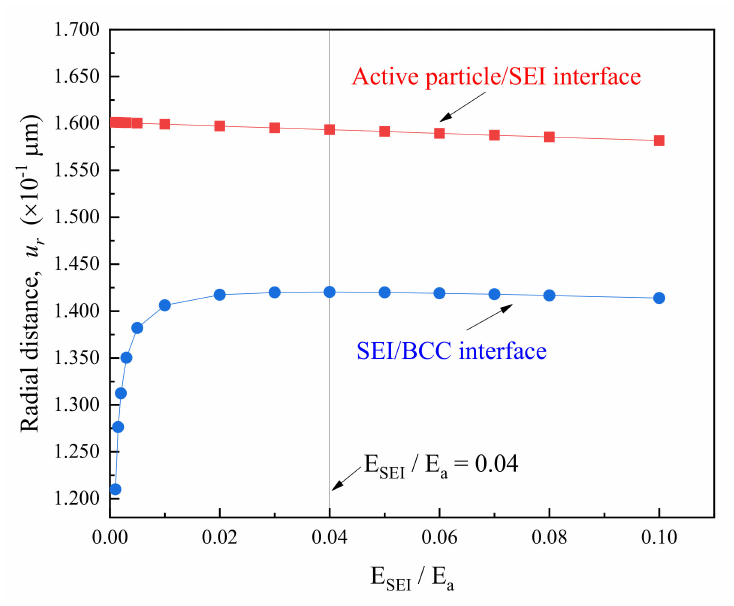
Figure 8. E ff ect of relative modulus ( E SEI / E a ) of SEI to active particle on interfacial